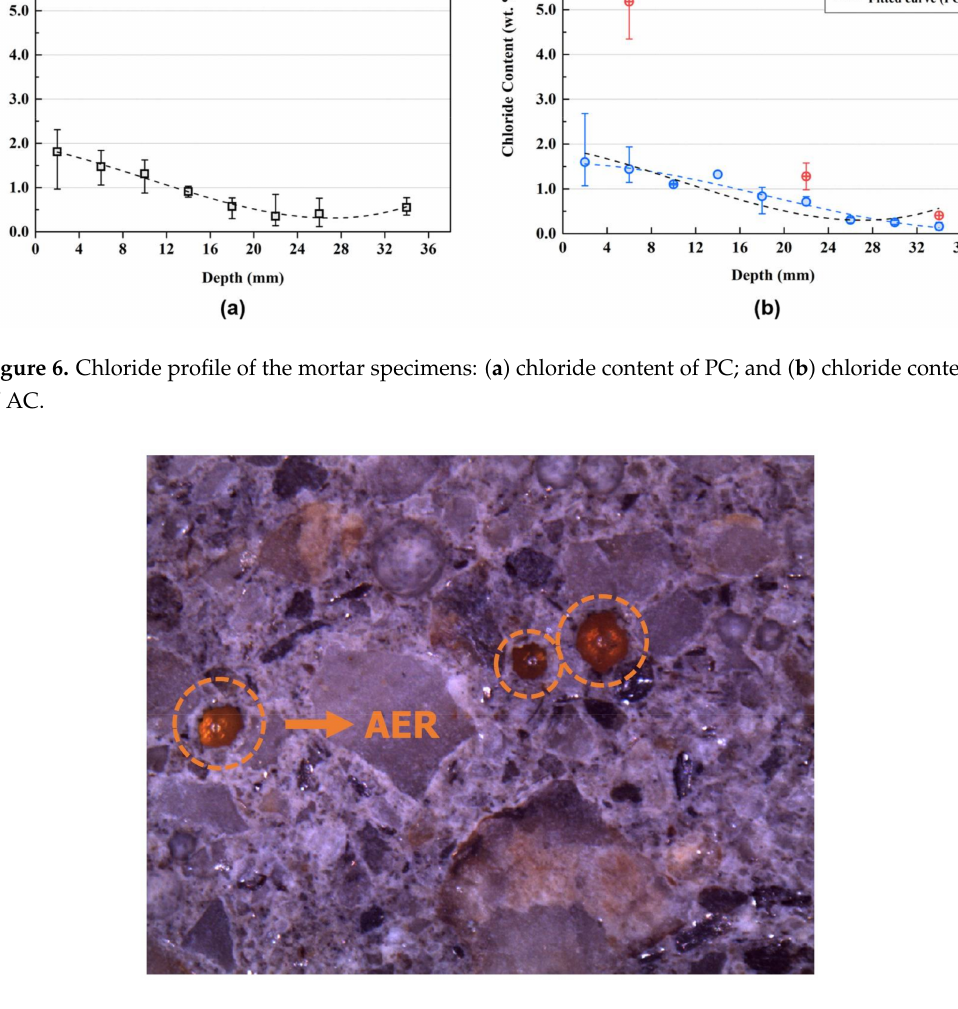
Figure 7. Section of the mortar specimen containing the AER.